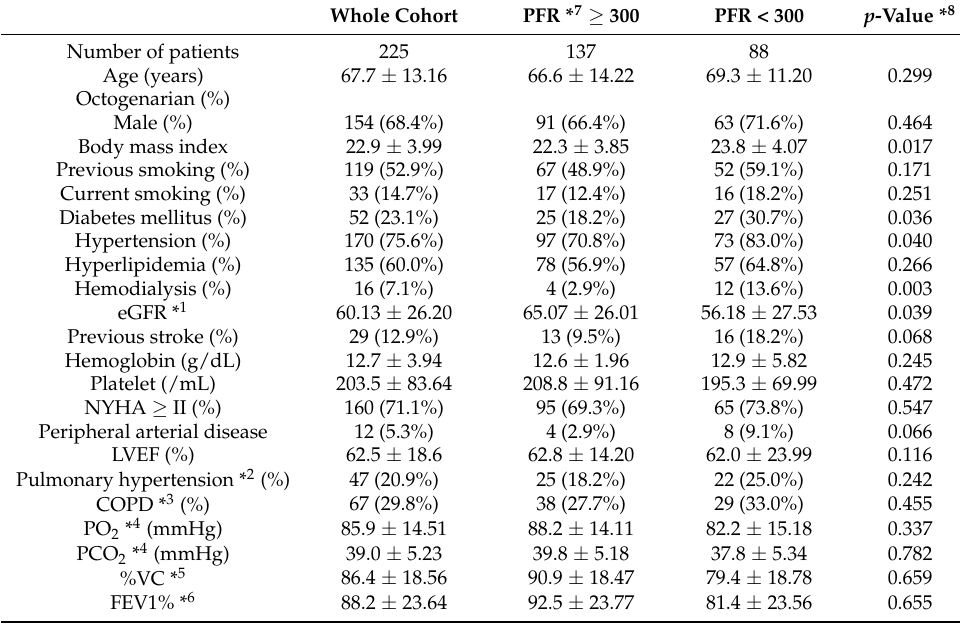
Table 1. Baseline characteristics.